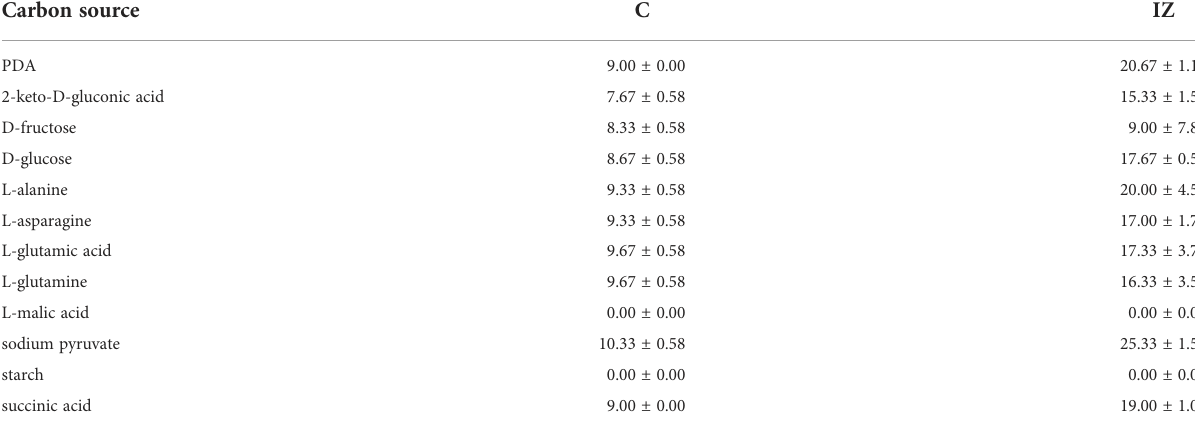
TABLE 4 Colony diameter (C, mm) and colony + inhibition zone diameter (IZ, mm) caused by P. resinovorans SZMC 25872 on A. tumefaciens SZMC 14557 in the presence of different carbon sources (means of 3 replicates ± standard deviations). Carbon